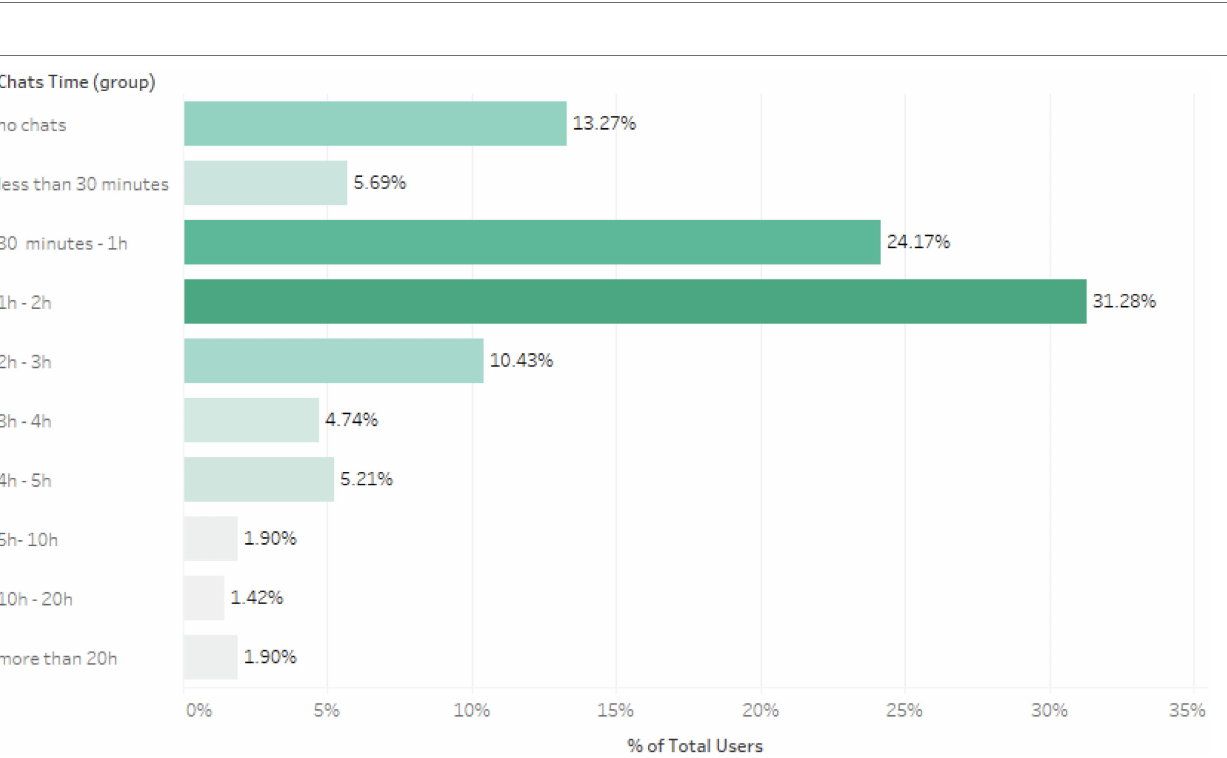
FIGURE 1 | The age distribution of individuals who set goals in Kooth Student.